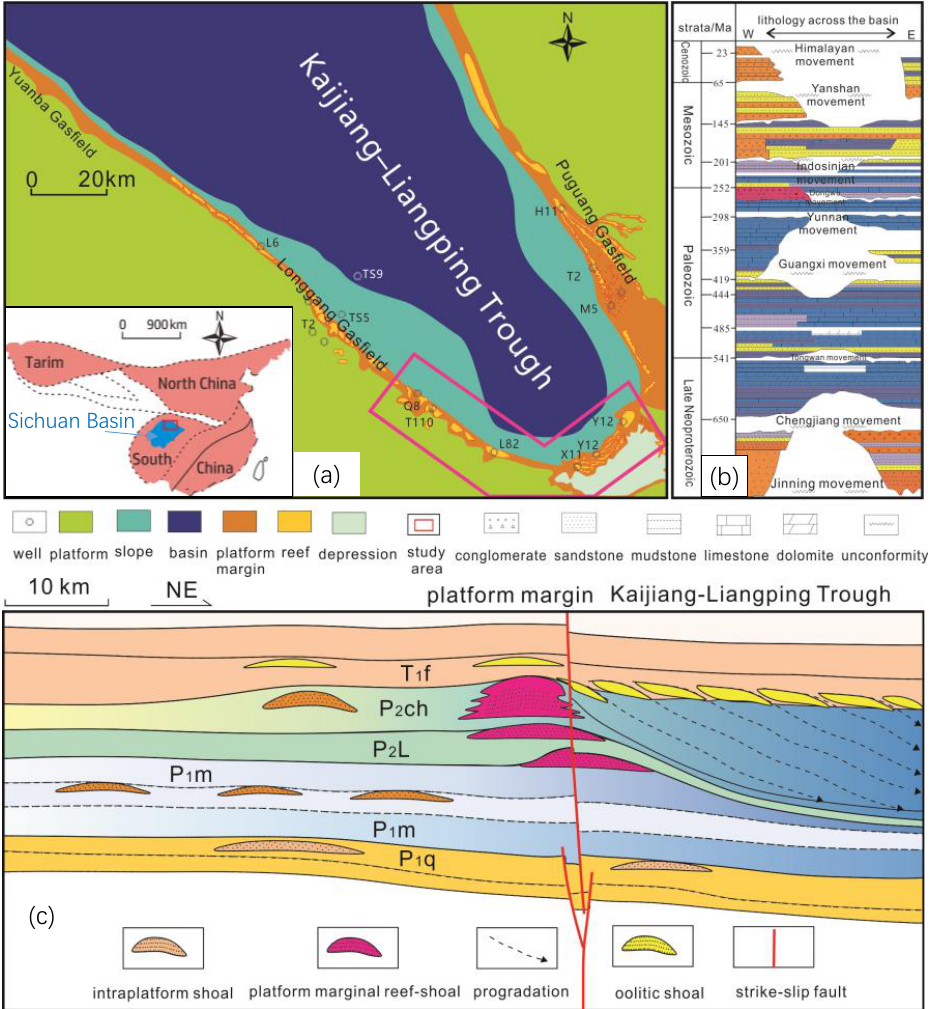
Figure 1. ( a )The outline of the Kaijiang – Liangping Trough (Inset shows regional location), ( b ) the stratigraphic column, and ( c ) the geological section across the Permian-Triassic platform margin (revised from References [21,23,32]).